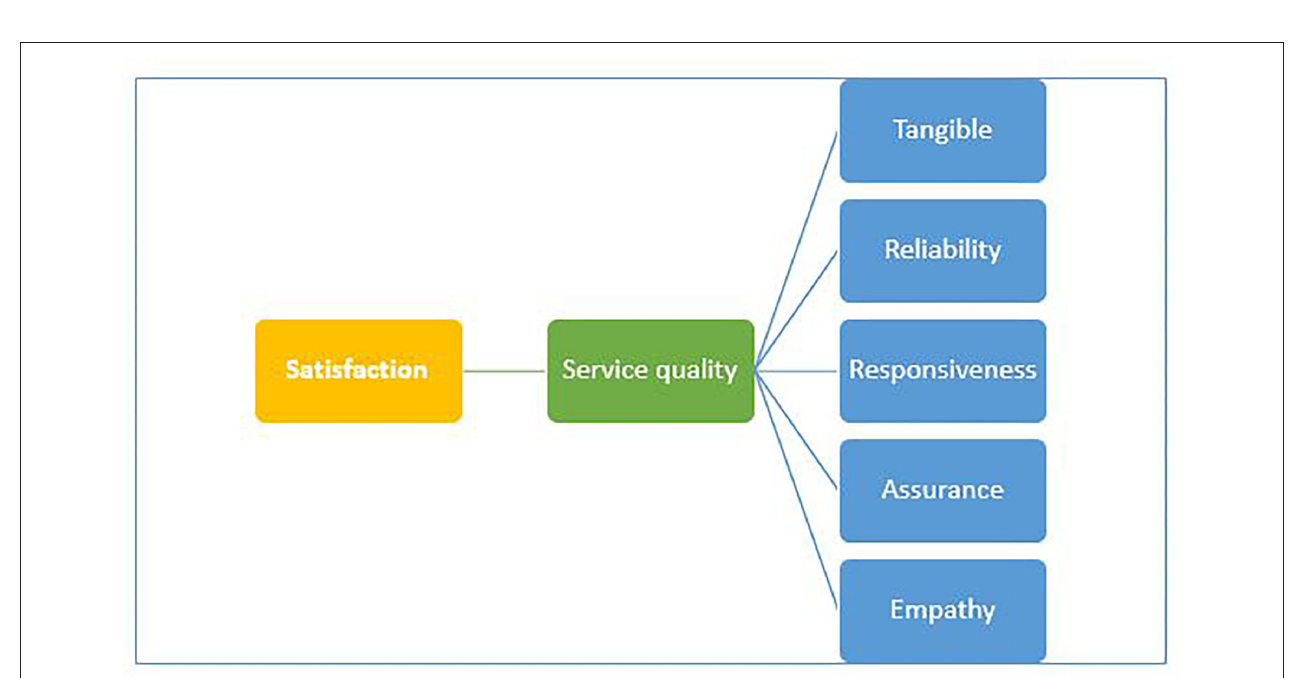
FIGURE 2 | Conceptual framework of the impact of service quality and farmer’s satisfaction.